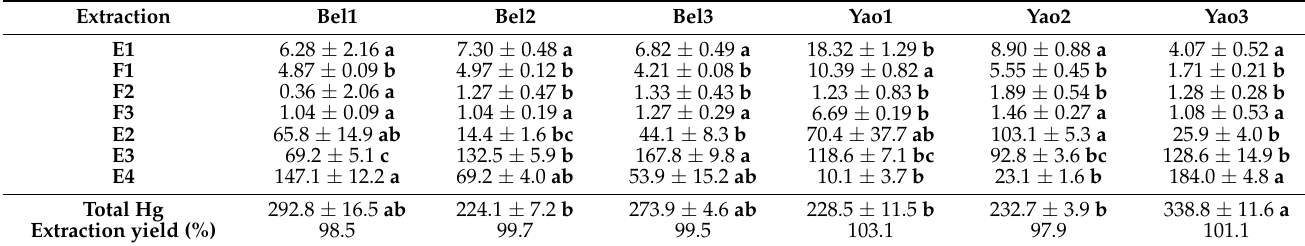
Table 3. Mercury environmental speciation for the six sites. E1: Extraction of highly mobile mercury species, F1: H 2 O soluble mercury fraction, F2: CaCl 2 exchangeable mercury fraction, F3: EDTA bioavailable mercury fraction, E2: Extraction of mobile and toxic mercury species, E3: Extraction of semi mobile mercury species, E4: Non-mobile mercury species. All values are expressed in ng g − 1 soil. Extraction yield represents the quality of mercury extraction in the samples, the value is obtained with the following formula: (E1 + E2 + E3 + E4)/Total Hg × 100. For each parameter, values followed by different letters differ significantly with p < 0.05 with Tukey HSD